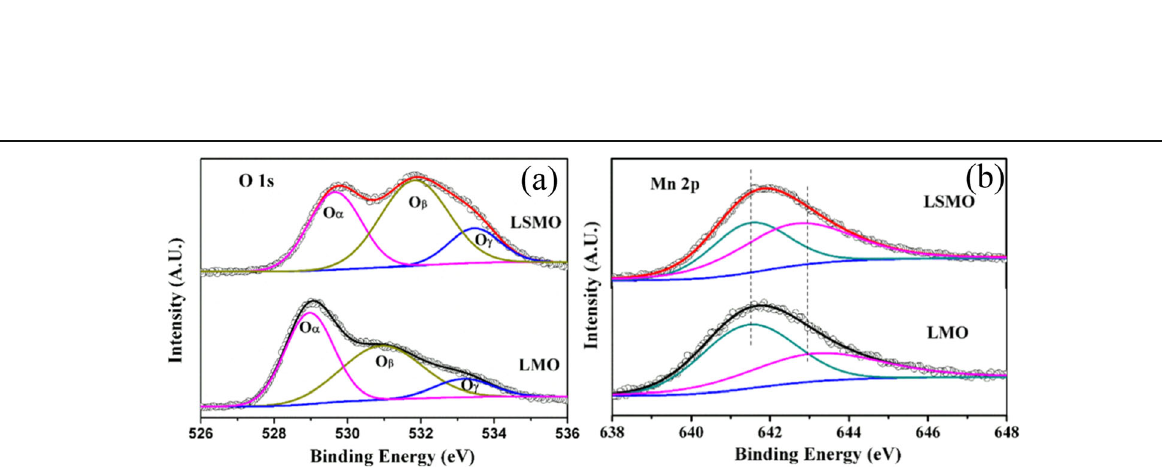
Fig. 7 a Mn 2p3/2 and b O 1s XPS spectra of LaMnO 3.15 (LMO) and La 0.67 Sr 0.33 MnO 2.91 (LSMO) nanoparticles. Reproduced with permission of